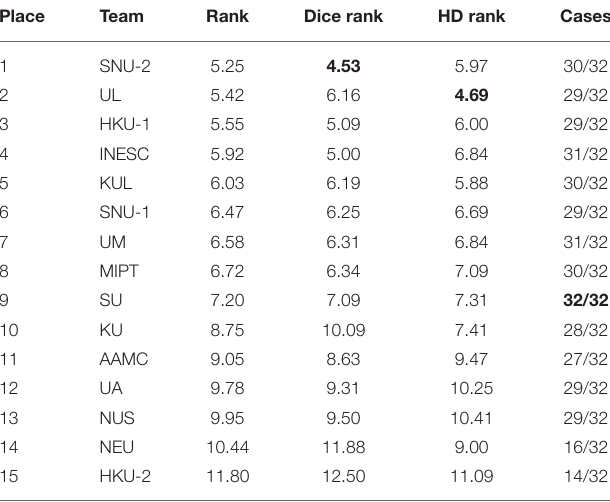
TABLE 7 | Average Dice score, precision and sensitivity for individual teams across all 32 cases for ISLES 2017. Place Team Dice Precision